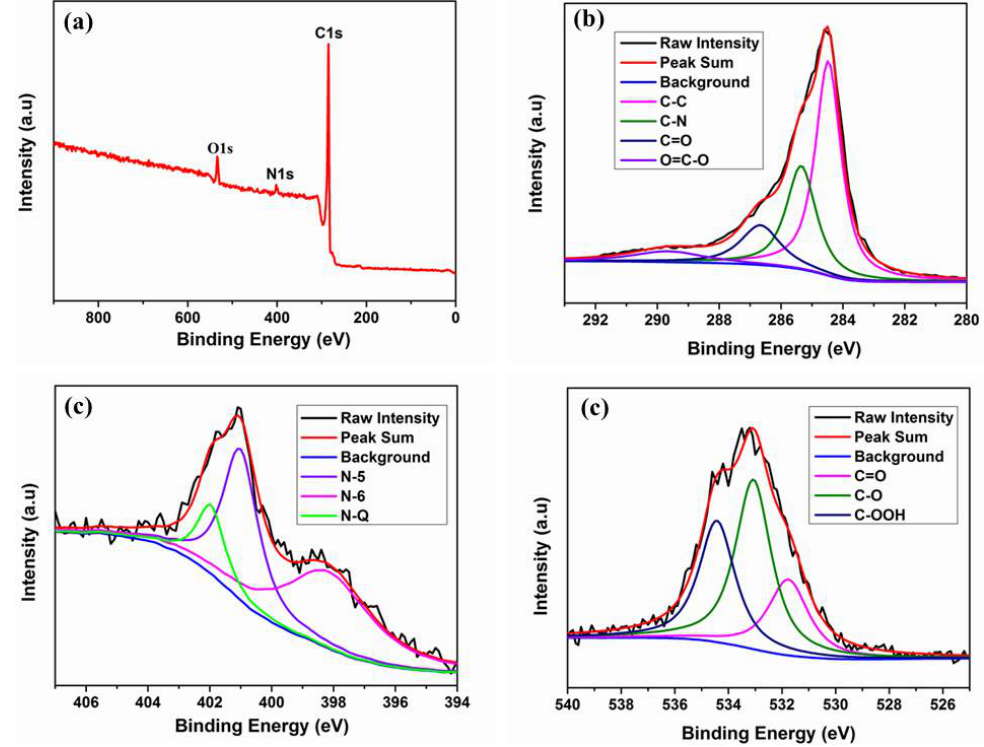
Figure 4. The XPS spectra of NCNBs-45 ( a ) total spectrum; ( b ) C1s XPS peaks; ( c ) N1s XPS peaks and ( d ) O1s XPS peaks.